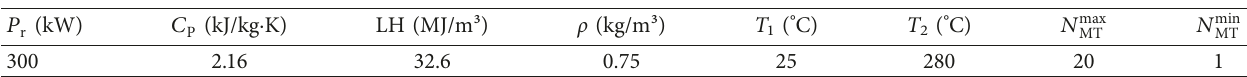
Table 5: MT parameters.